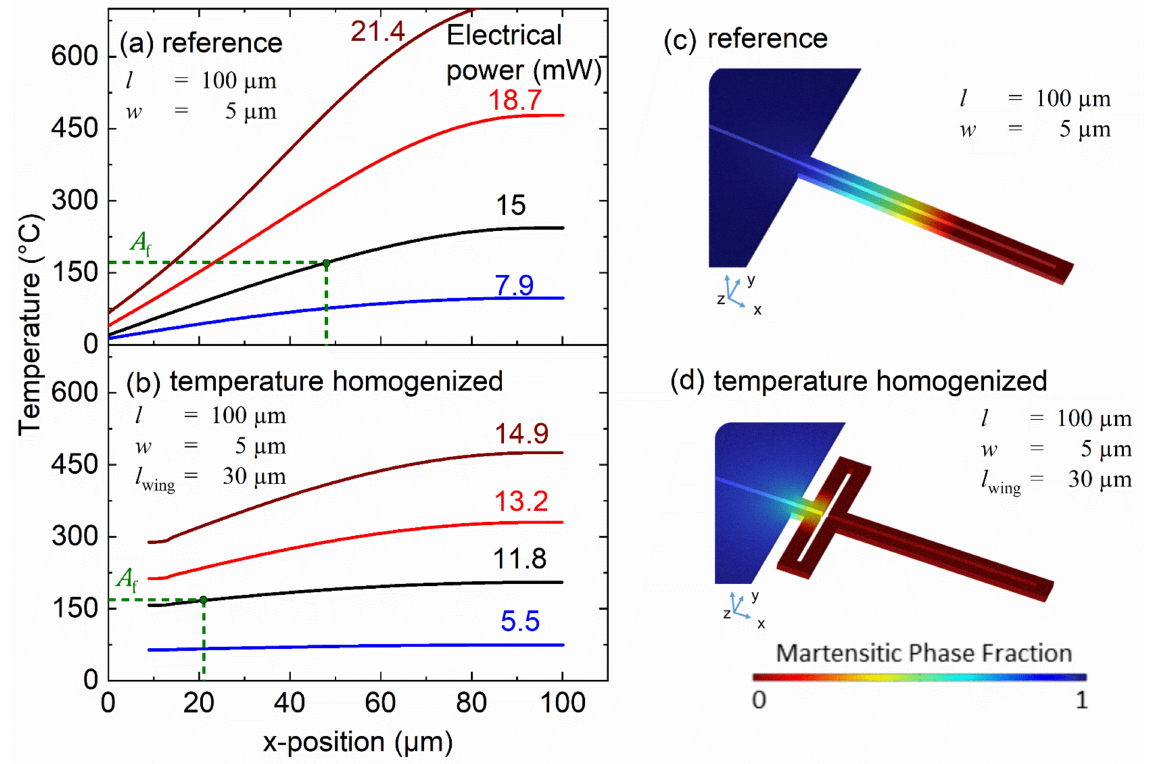
Figure 2. ( a , b ): Coupled finite element simulation of the temperature profiles along x-direction of a TiNiHf/Si cantilever beam upon Joule heating for various values of electrical power. The beam length l , beam width w and length of folded beams l wing are indicated. The reference de- sign without additional folded beams shows much larger temperature gradients compared to the temperature-homogenized design with additional folded beams; ( c , d ): contour plots of martensite phase fraction for reference and temperature-homogenized design at an electrical power of 15 mW and 11.8 mW,